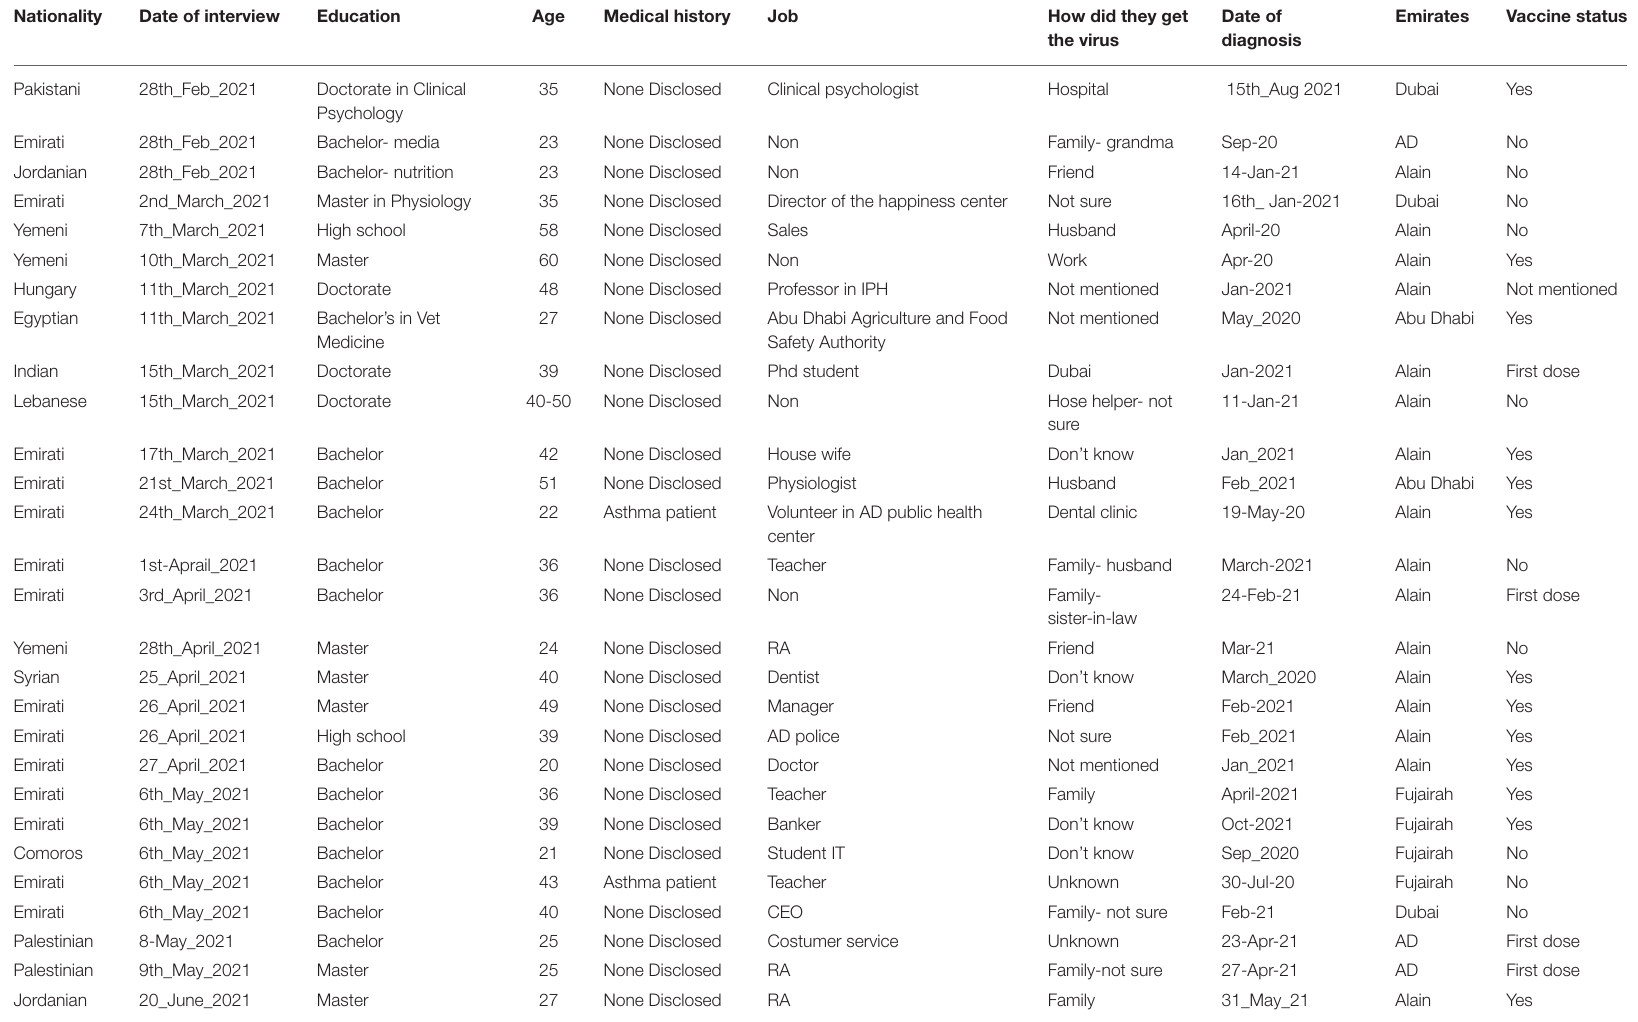
TABLE 1 | Demographic characteristics of the